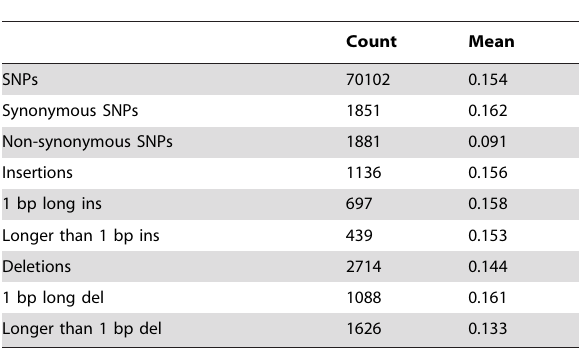
Table 2. Mean sample frequencies.